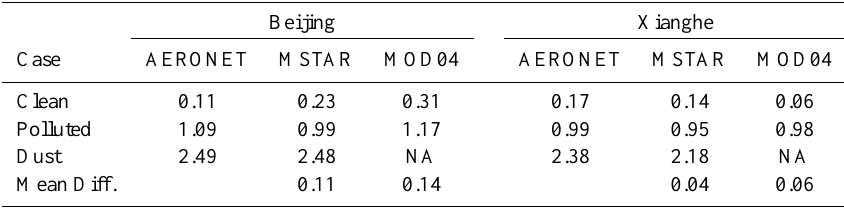
Table 3. Comparison between MSTAR AOT and AERONET AOT at Beijing (116.38 ◦ E, 39.98 ◦ N) and Xianghe (116.96 ◦ E, 39.75 ◦ N) stations for clean, polluted, and dust storm